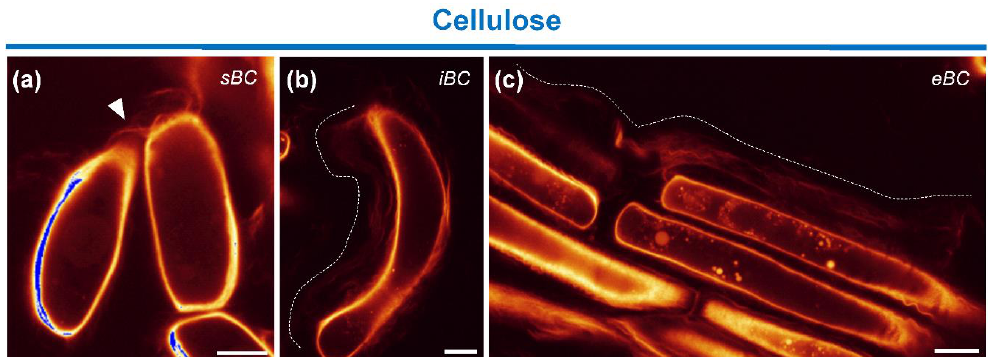
Figure 7. Staining of crystalline cellulose with the probe Direct Red 23. ( a – c ) Fluorescence images showing a strong staining of the cell wall of all BC morphotypes. A fibrillary material is also seen peeling off the cell surface into the extracellular space outside the cells (( b , c ) white dote line). Some cells are interconnected via fluorescently stained material (( a ) white arrowhead). sBC, spherical border cells; iBC, intermediate border cells; eBC, elongated border cells. Scale bar: 10 µm.